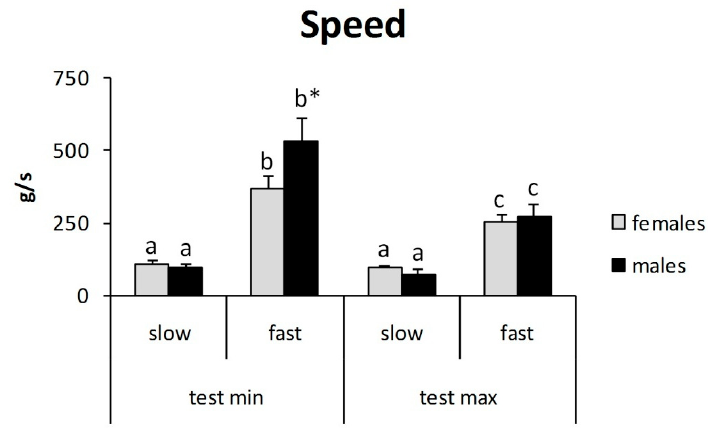
Figure 4. Speed test: difference between fast and slow test. * p < 0.01.